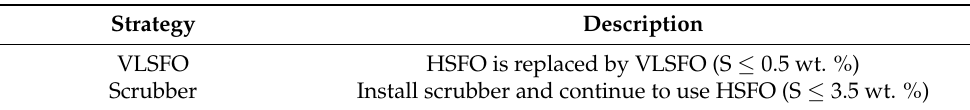
Table 1. Abbreviations for strategies evaluated in this study.